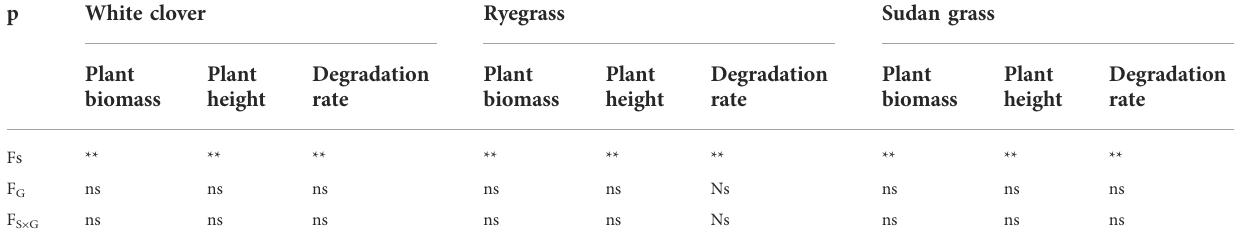
TABLE 7 Analysis of soil types, glycine addition and their interaction. p White